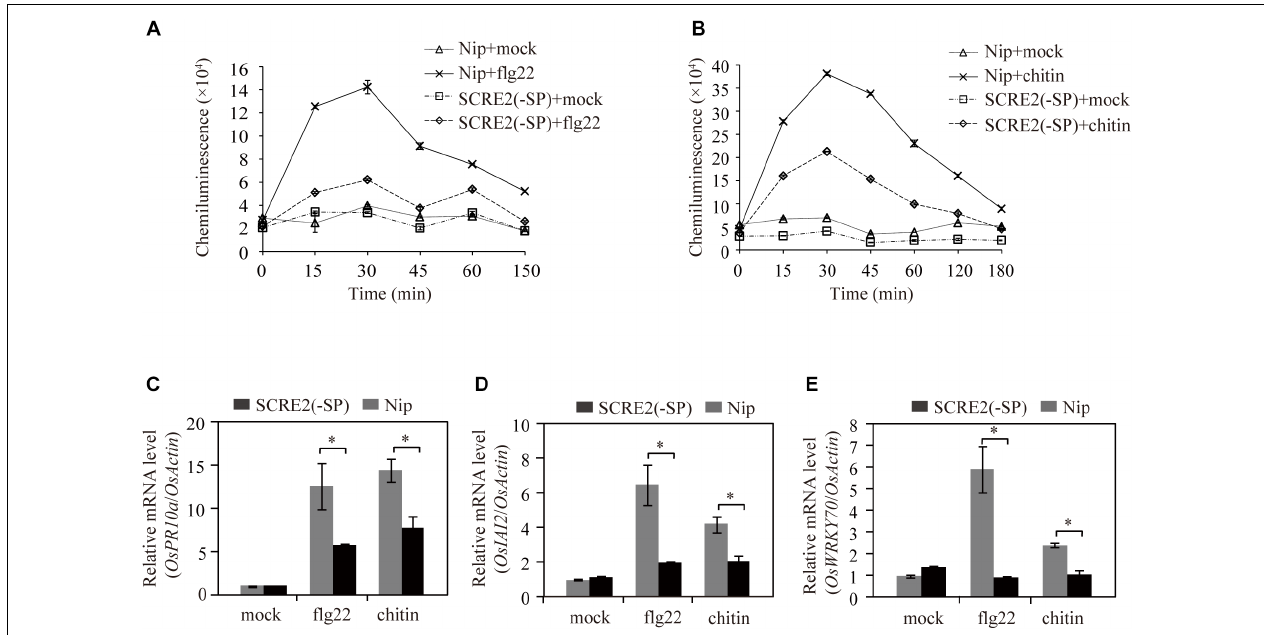
FIGURE 5 | Heterologous expression of SCRE2 in transgenic rice cells inhibits rice immunity. (A,B) ROS burst induced by flg22 (A) and chitin (B) was significantly suppressed in SCRE2(-SP) transgenic cell cultures compared with that in the wild-type (Nip) cells. ROS generation induced by flg22 and chitin was detected by luminol-based chemiluminescence assays. (C–E) Expression of the defense genes OsPR10a (C) , OsIAI2 (D) , and OsWRKY70 (E) triggered by flg22 and chitin was significantly inhibited in SCRE2(-SP) transgenic cell cultures compared with that in the wild-type cells. The OsActin gene was used as an internal control. Means ± standard errors are shown. Asterisks ( ∗ ) indicate significant difference in the expression levels of defense marker genes between the wild-type and SCRE2(-SP) transgenic cell lines ( P < 0.05). SCRE2(-SP) : the SCRE2 gene lacking DNA sequences encoding the signal